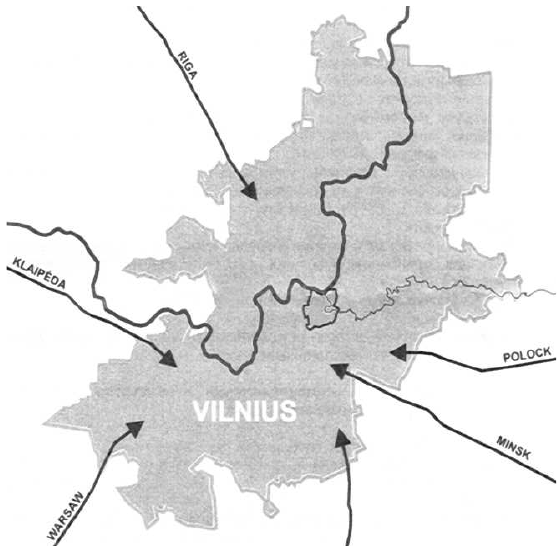
Fig 14. Scheme of relationship between old town and city administrated territory